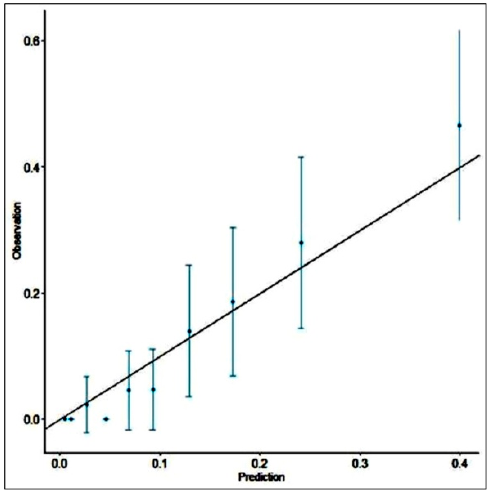
Figure 2. Calibration graph of the mortality prediction of the SRC.